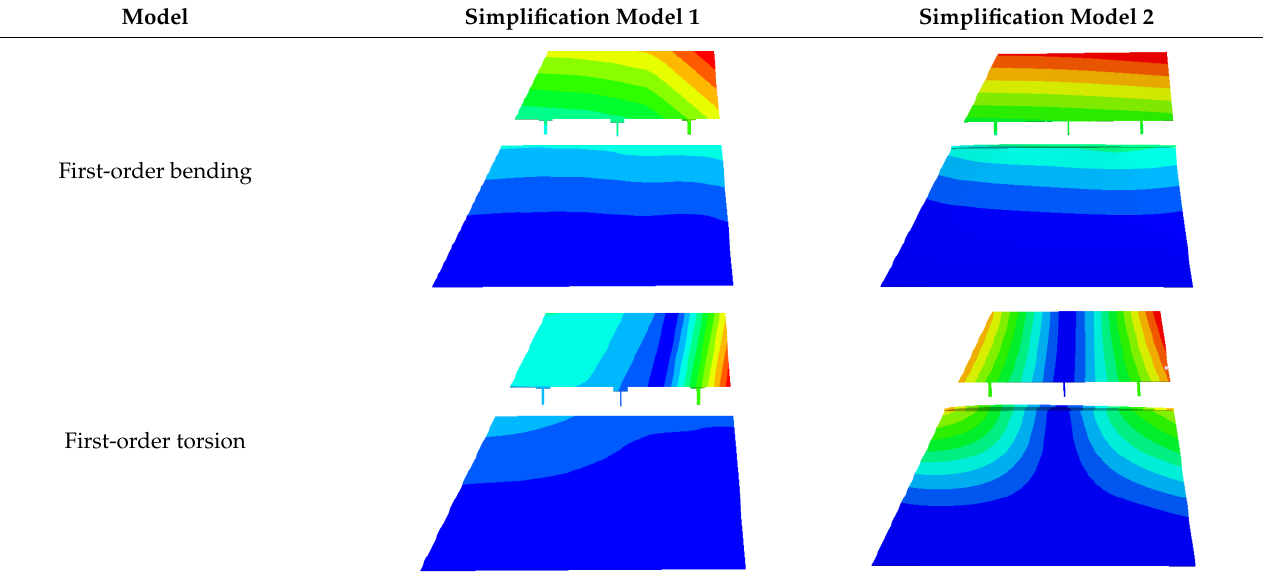
Table 6. Vibrational modes of the two FEM simplified models.